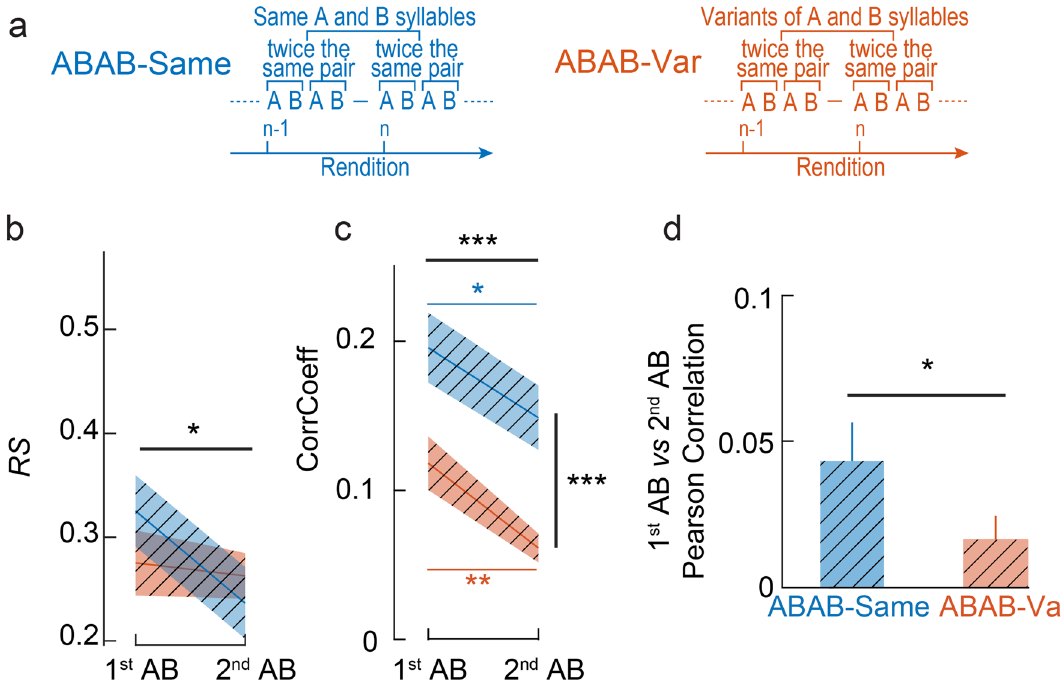
Figure 5. Responses to the two AB pairs that form ABAB sequences reflects sensitivity to the context in awake birds. ( a ) For ABAB-Same series, the same syllables A and B were used to build pairs of syllables AB that were repeated twice within a sequence, so two consecutive sequence renditions (n) include two repetitions of the same pairs of syllable AB. For ABAB-Var series, variants of the syllables A and B were used to build pairs of syllables AB that were repeated twice within a sequence so two consecutive sequence renditions include variants of the pairs of syllable AB repeated twice. ( b ) Strength of responses ( RS values) changed from the first AB pair to the second one. The exposure to the first pair of syllables AB impacts the responses to the second pair of syllables AB within a stimulus rendition in awake birds ( b – d ). Evoked auditory responses ( b ) and CorrCoef ( c ) were overall higher for ABAB-Same than for ABAB-Var sequences and were lower for the second pair of syllables AB than for the first pair. Yet, Pearson correlation coefficient measured on each individual spike train between the first and second pair of syllables AB was lower for ABAB-Var than ABAB-Same sequences ( d ). *, ** and ***, p < 0.05, 0.01 and 0.001, respectively (see main text for statistics